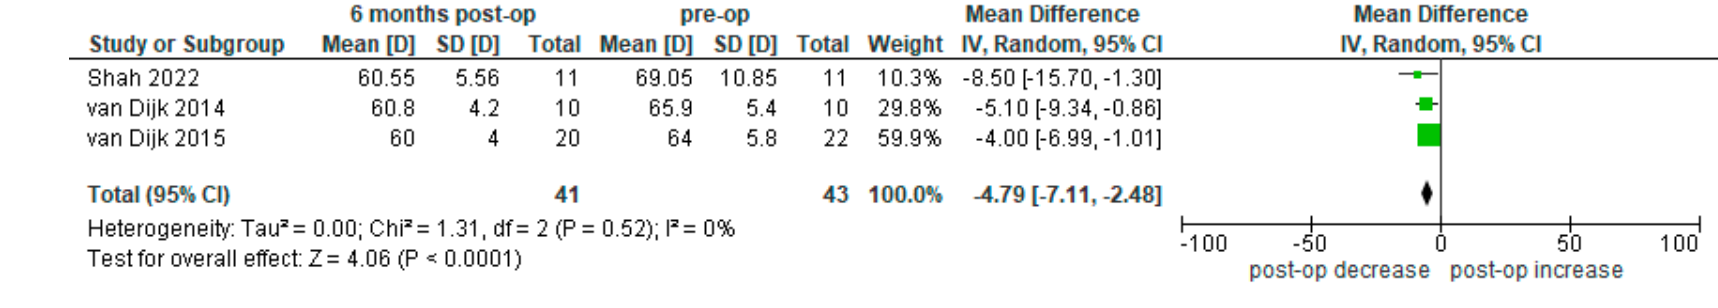
Figure A12. Di ff erence in mean simulated keratometry in 3 studies [27,31,35]. Figure A12. Difference in mean simulated keratometry in 3 studies [27,31,35].